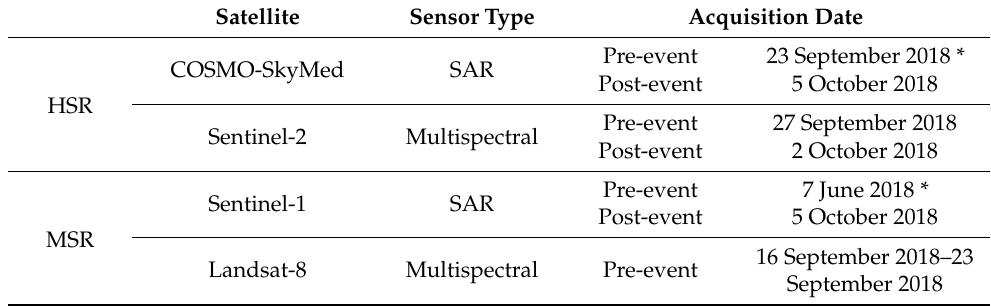
Table 1. Satellite images used in this